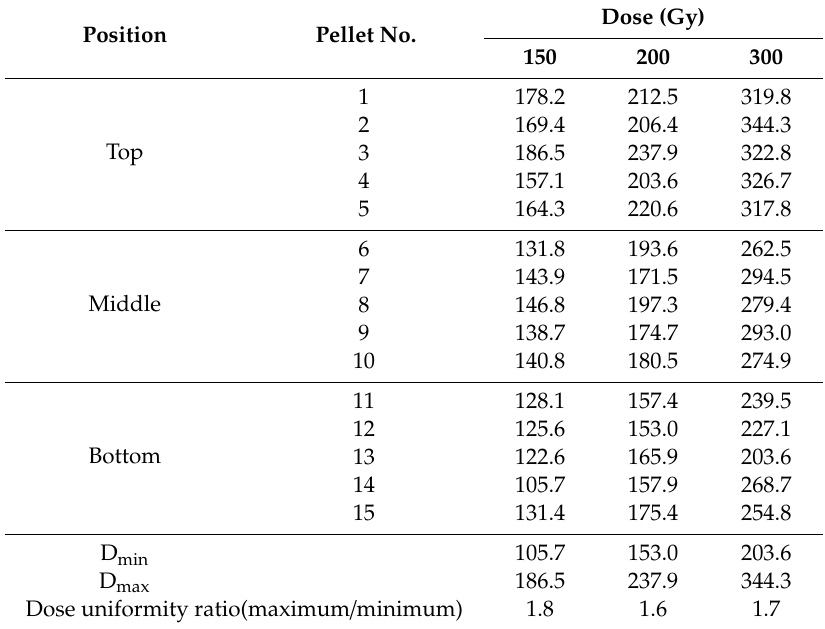
Table 5. Dose mapping of X-ray in boxes filled with strawberry fruits. Position Pellet No.